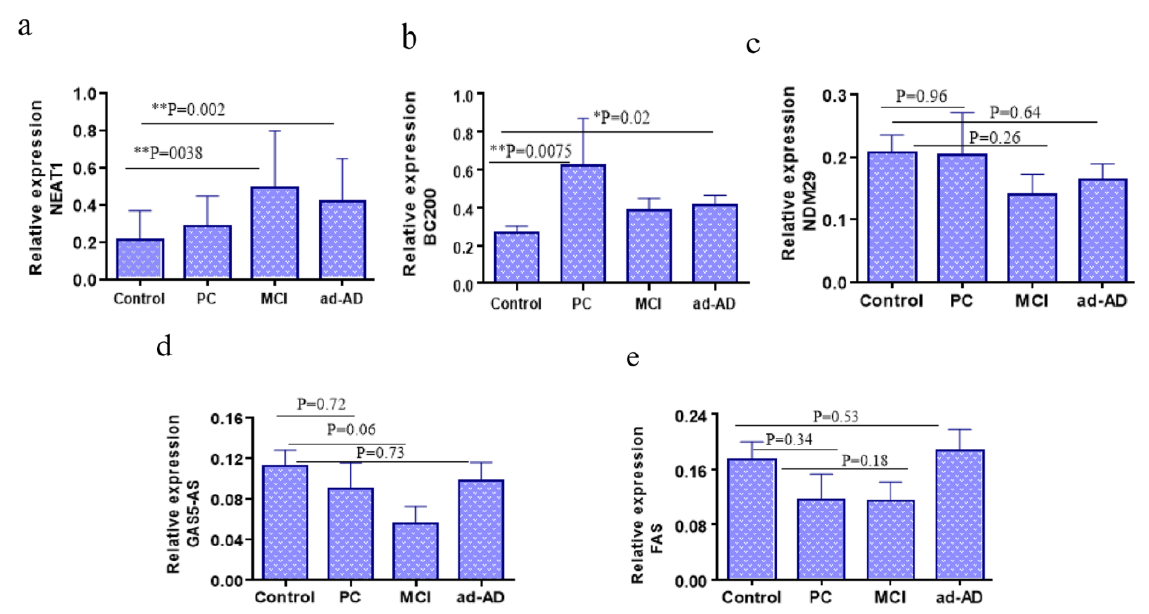
Figure 3: Comparison of the plasma levels of the studied lncRNAs between AD subgroups. The patients’ group was divided into preclinical-AD (PC) (MMSE 24-26), MCI (MMSE 20-23) and advanced- AD (ad-AD) (MMSE<19) subgroups based on the corresponding MMSE scores of the subjects. Com- paring the plasma levels of a ) NEAT1 and b ) BC200 between AD subgroups showed statistically signif- icant differences. However, these comparisons for c ) NDM29, d ) GAS5-AS1 and e ) FAS-AS1 did not show any significant differences. P values are listed above each